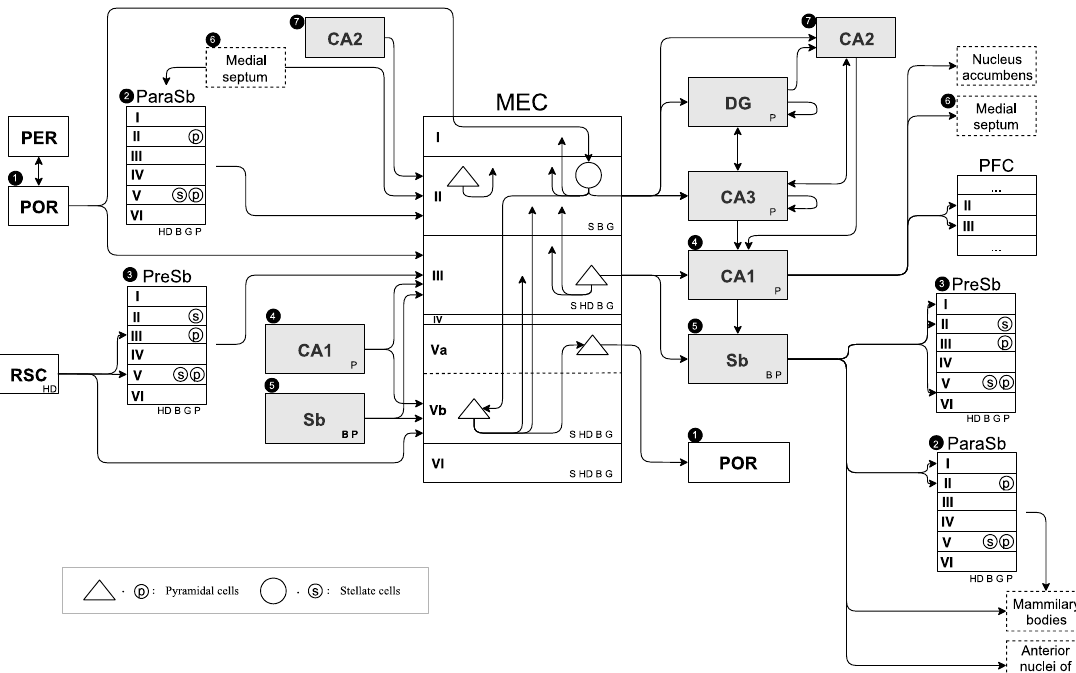
Figure 1. Schematic diagram of neural circuit (SDNC). Single arrow denotes projection in one direction, and double arrow denotes projection in both directions. Arrow starting points of presubiculum (PreSb) and parasubiculum (ParaSb) projected to medial entorhinal cortex (MEC) are slightly away from the square that represents their regions because their output layers are still unclear. However, it is clear that PreSb and ParaSb project to MECII and MECIII, respectively. Dotted squares represent limbic systems other than hippocampal formation, and solid squares represent other regions. Gray squares represent regions without a six-layer structure, dentate gyrus (DG), CA1, CA2, CA3, and subiculum (Sb); white squares represent other regions with layer structures. Some layer structures of the perirhinal cortex (PER), postrhinal cortex (POR), retrosplenial cortex (RSC), and prefrontal cortex (PFC) were omitted. Connection between some other regions was also omitted to precisely describe input / output relationship between MEC and other regions. Numbers 1–7 in black circles denote that same regions were drawn twice on both MEC input and output sides. Stellate cells and pyramidal cells were drawn inside layers of MEC, PreSb, and ParaSb. Cell firing patterns of speed (S), head-direction (HD), border (B), grid (G), and place (P) cells were drawn in regions where they are present. In PreSb and ParaSb, it is not clear which cell-firing pattern exists in which layer, so cell-firing pattern was drawn in the lower right corner of the square of the region.